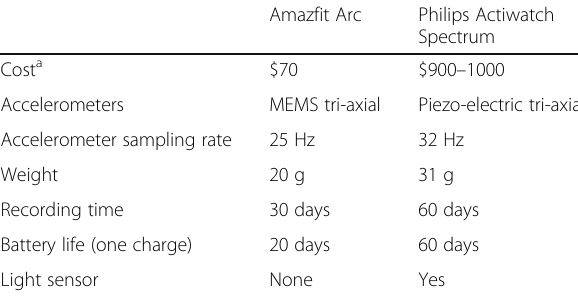
Table 1 Comparison of consumer- and research-grade